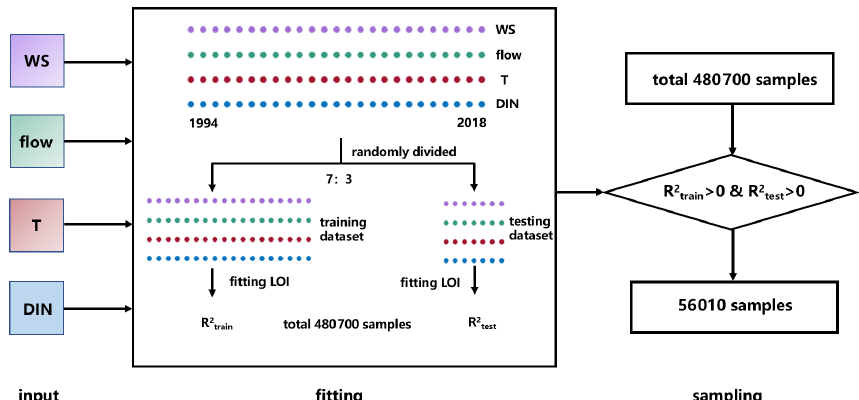
Figure A4. Flowchart describing the fitting of LOI and the case sampling used for